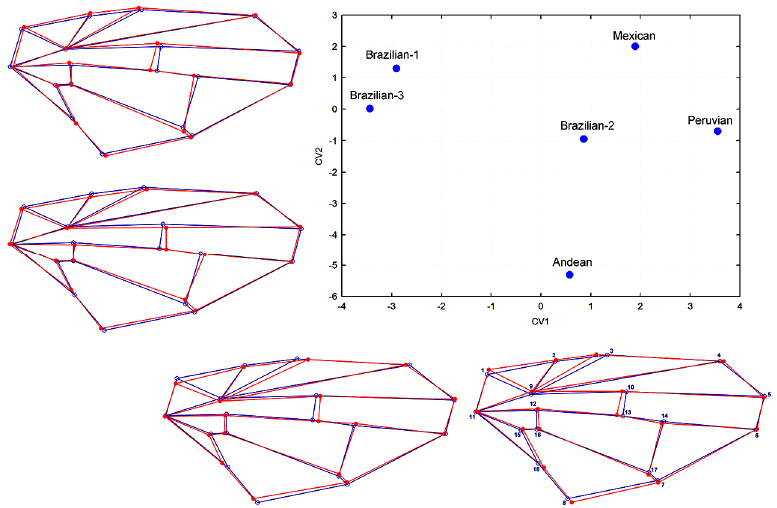
Figure 7. Centroid function and shape deformation of female wing shapes. Graph showing the centroid functions of the first two canonical variates based on 18 landmarks of wings resulting from comparisons among the six AF complex morphotypes. Wireframes show shape deformations (red line) from the configuration consensus (blue line) for each positive and negative (scale factor 10) extreme canonical